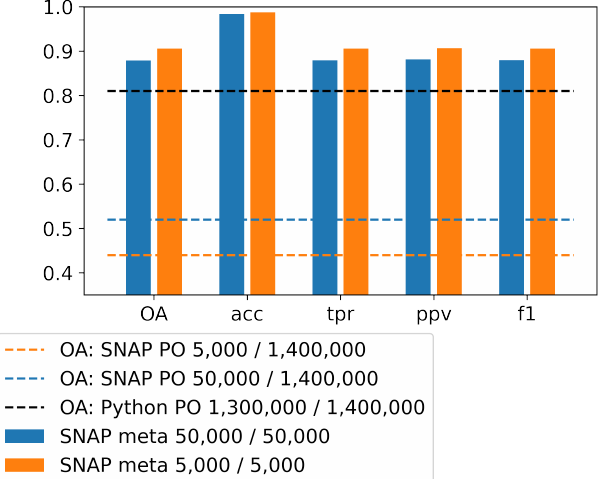
Figure 6. Accuracy metrics calculated for the result of the classification performed in SNAP using 50000 and 5000 training samples. For comparison, the OA obtained in the classification using our own scripts in Python (black dashed line).